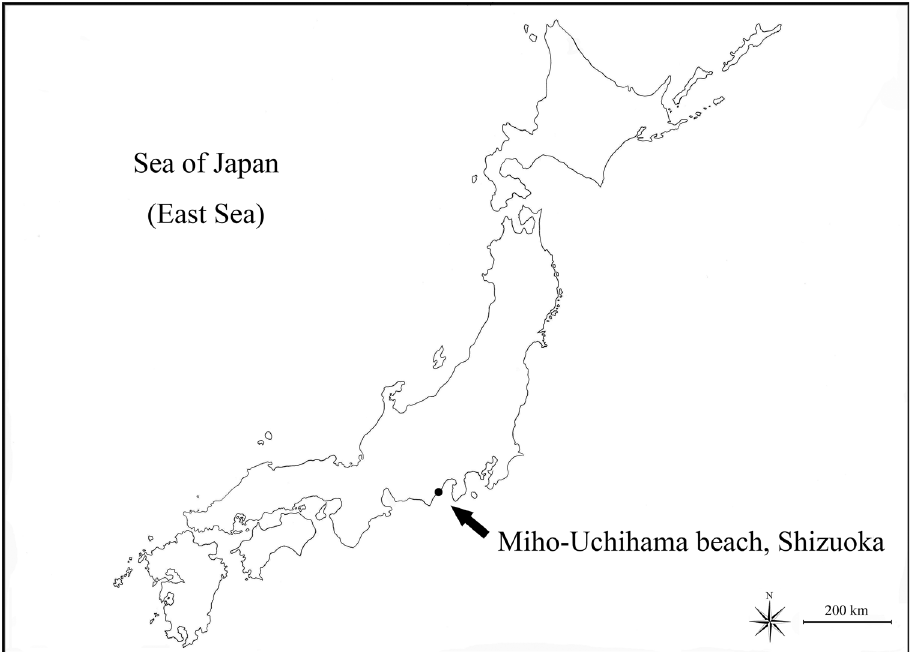
Figure 1. Sampling site. The arrow indicating the type locality of Microcharon tanakai sp. n. (Miho- Uchihama beach, Shizuoka,